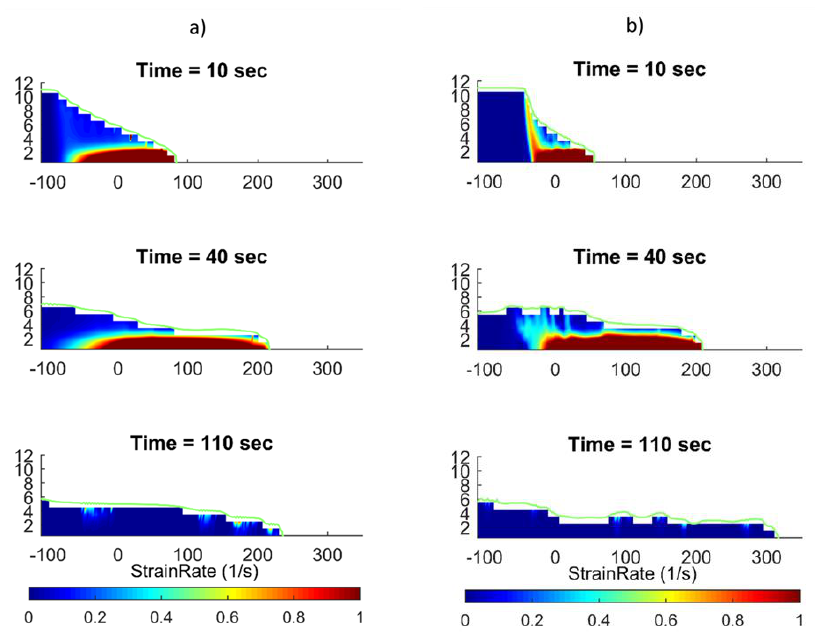
Figure 13. Snapshots of strain rate profile on the centerline cross-section of the breach (y = 220 m). ( a ) Bingham model (BM); ( b ) modified bi-viscosity model (MBM).